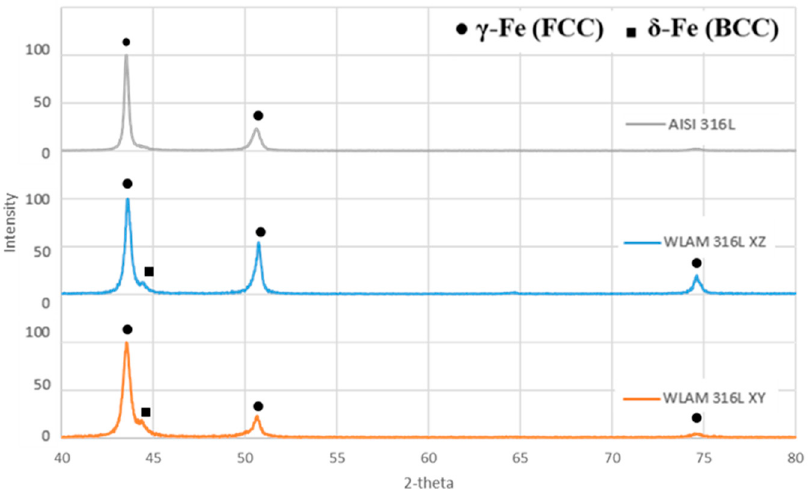
Figure 2. X-ray diffraction analysis of the WLAM 316L sample (in XY and XZ planes) and the counterpart AISI 316L alloy.